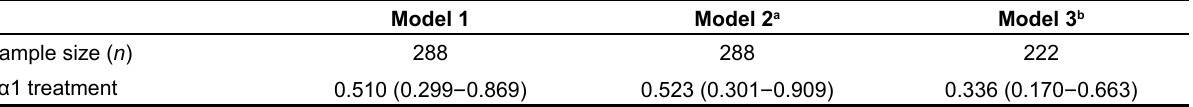
Figure 3. ΔSOFAday07 classification in patients with sepsis. A: Total patients in Tα1 group (left) and placebo group (right); B: PSM patients in Tα1 group (left) and placebo group Table 3. Tα1 treatment was associated with higher ΔSOFAday07 in patients with sepsis